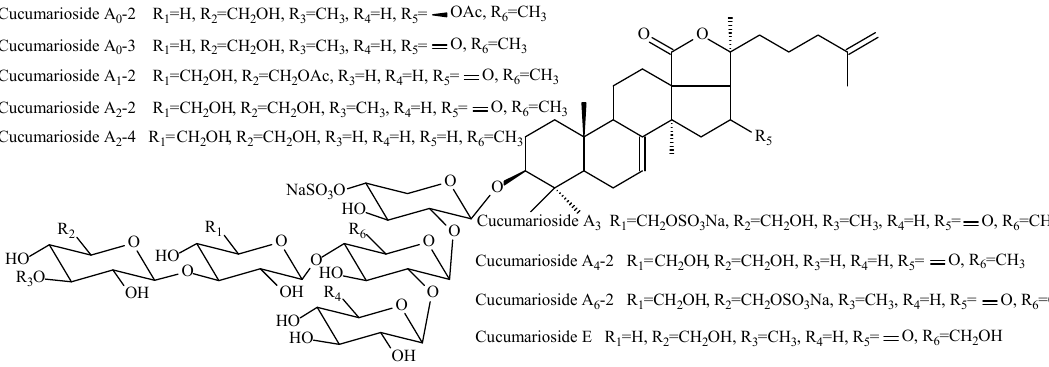
Figure 1. Structure of triterpene glycosides from the supercritical extract of C. frondosa japonica .